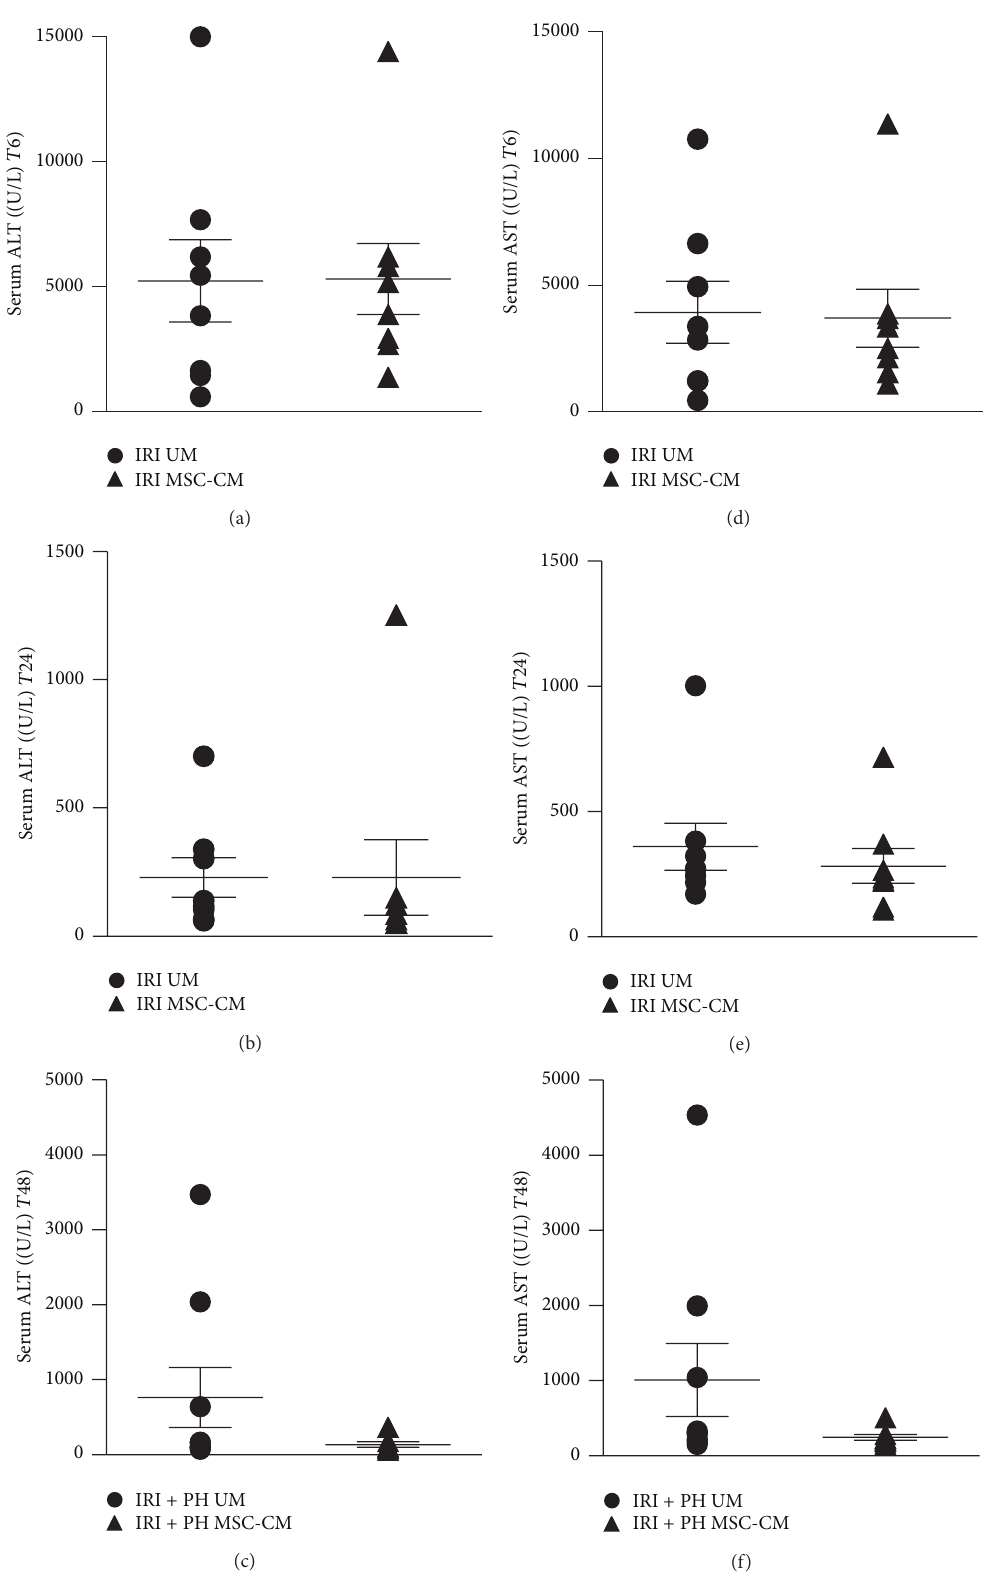
Figure 3: Effects of MSC-CM on serum injury markers. Serum ALT levels at (a) 6 hours after IRI, (b) 24 hours after IRI, and (c) 48 hours after IRI + PH. Serum AST levels at (d) 6 hours after IRI, (e) 24 hours after IRI, and (f) 48 hours after IRI +